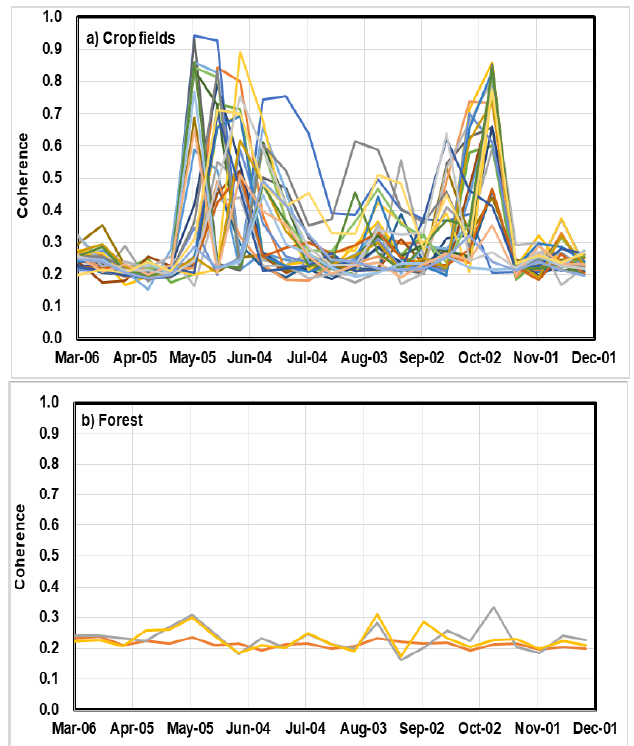
Figure 3. Typical seasonal variation of InSAR coherence for the study area during May 6–December 1 2019: ( a ) crop fields and ( b ) forest.